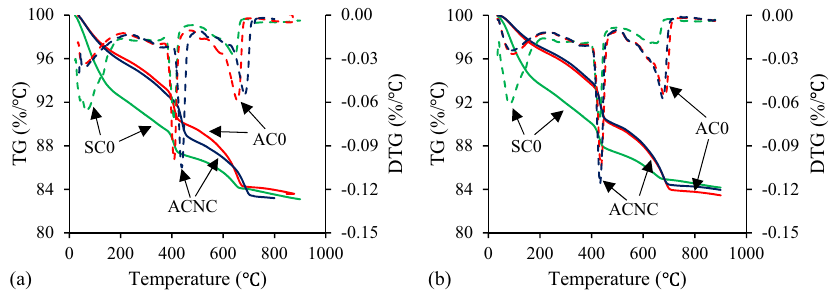
Figure 5: TG – DTG curves of di ff erent cement paste samples at di ff erent ages ( a ) 28 d ( b ) 300 d.